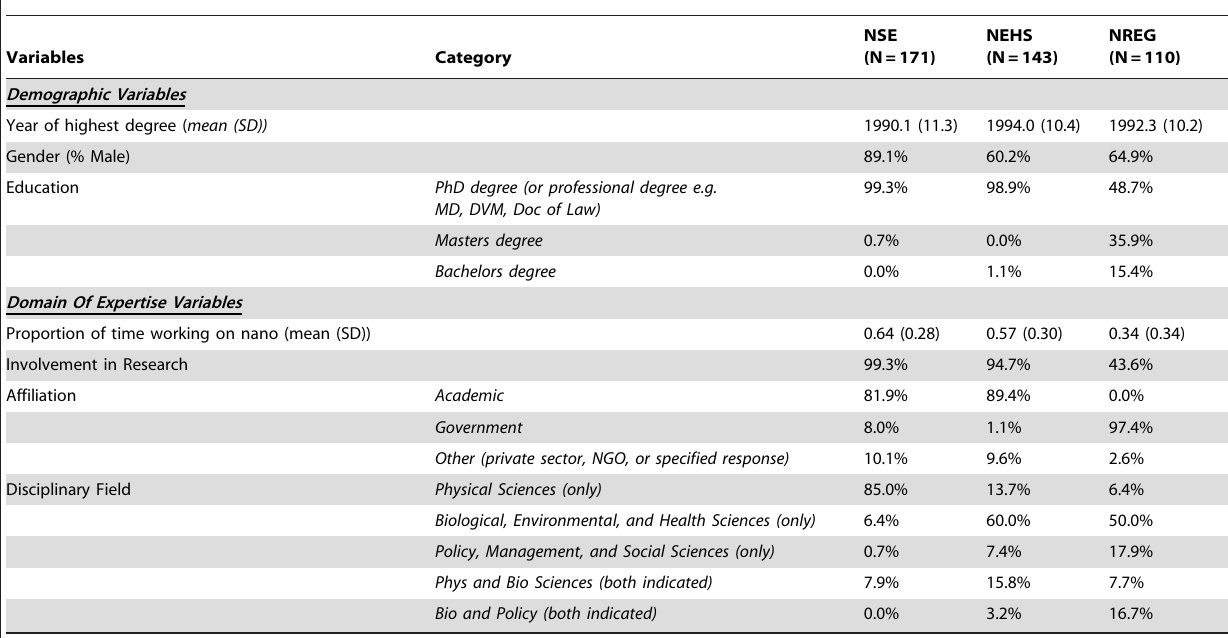
Table 1. Demographic and Domain of Expertise variables by expert